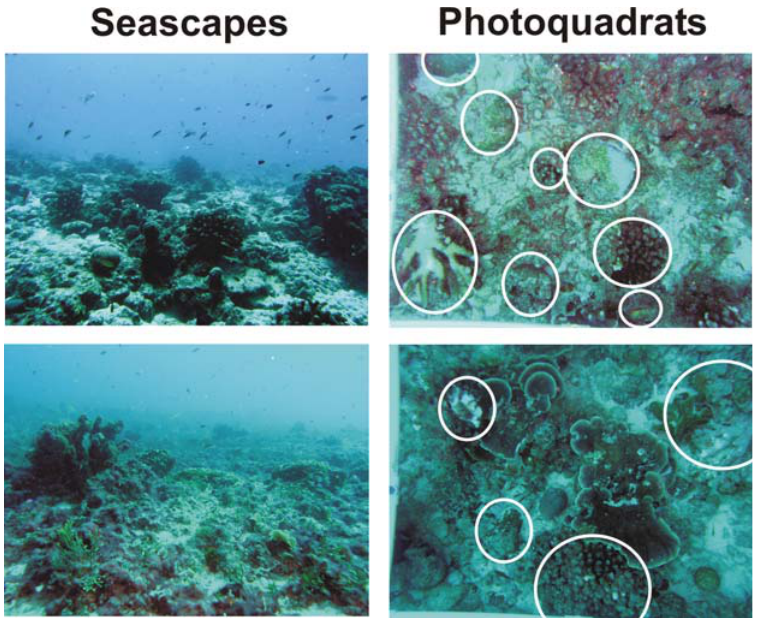
Figure 8. Seascape and photoquadrat photographs obtained from the metagenomic sampling site on Kiritimati. White circles indicate diseased, bleached, or recently dead corals.